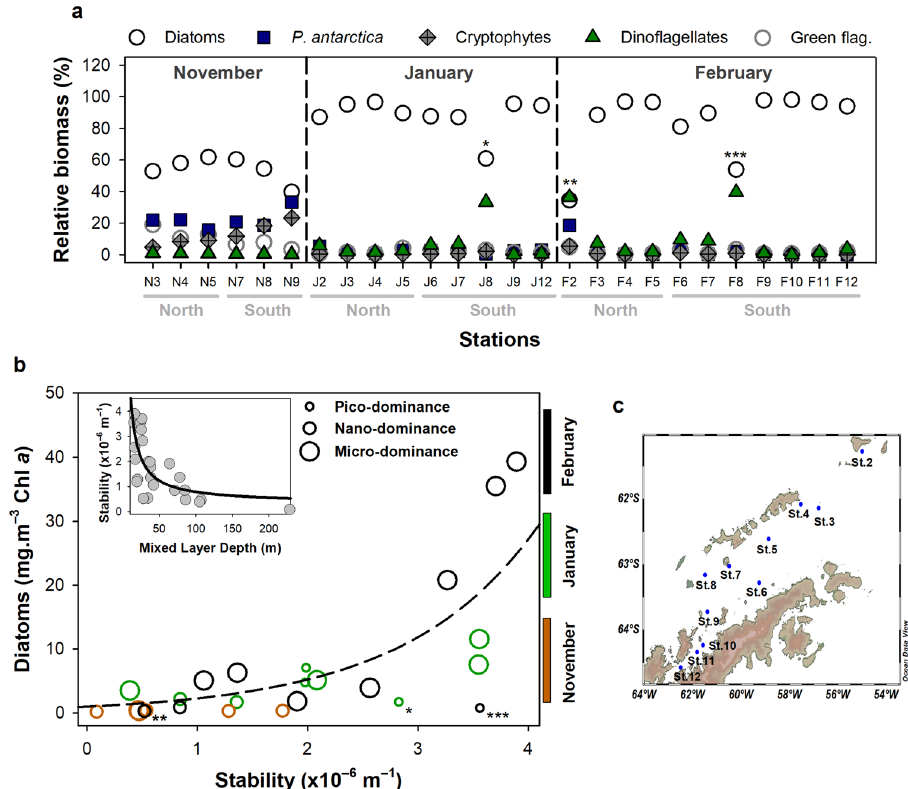
Fig. 3 Phytoplankton community composition and upper ocean physical structures along the NAP seasonal phytoplankton succession of 2015/2016. a Relative biomass (to the total in situ chlorophyll- a ; Chl- a ) distribution of phytoplankton groups on surface, via HPLC/CHEMTAX analysis, during spring/ summer of 2015/2016 along the NAP subregions. The black open circles indicate diatoms, the blue squares indicate Phaeocystis antarctica , the gray diamonds with crosses indicate cryptophytes, the green triangles indicate dino fl agellates, and the light gray open circles indicate green fl agellates. b Exponential curve ( R 2 = 0.57; p < 0.0001; n = 25) between upper ocean stability (Stability) and diatom absolute concentrations on surface. Symbol size indicates phytoplankton size class (pico-, nano- or micro-phytoplankton) that dominated with values >40% the community composition proportion in respect to the total Chl- a (considering the three fractionated size classes). Symbol color indicates the sampling month in respect to November (brown), January (gray), and February (black). The inset shows the polynomial inverse relationship ( R 2 = 0.51; p < 0.001; n = 26) between mixed layer depth (MLD) and Stability and indicates that a shallow MLD is not necessarily stable. The subregions are indicated by the underscore gray line below the stations ’ number ( a ). The letter N, J, or F (November, January, and February, respectively) denotes the respective month of data sampling according to locations of fi xed number stations represented by the map on the lower right corner ( c ). In ( a , b ), asterisks indicate decreased diatom proportion associated with increased dino fl agellate proportion during distinct moments of summer months (January and